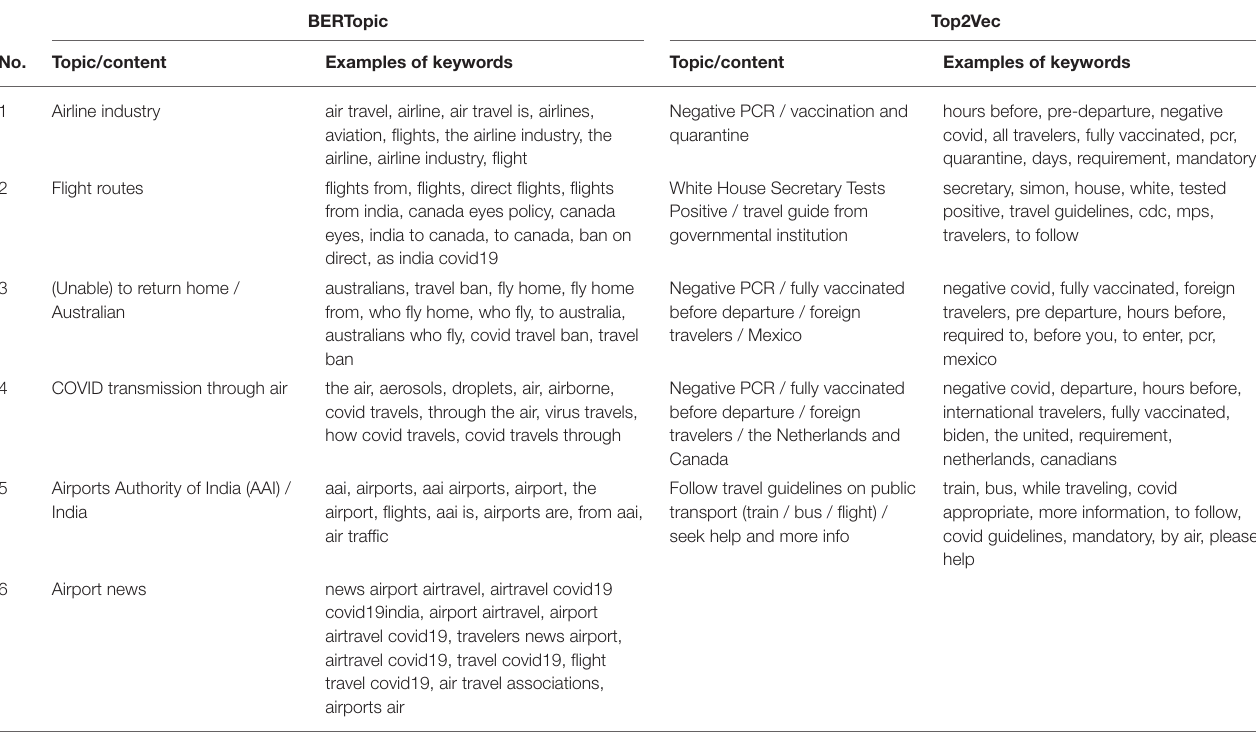
TABLE 2 | Topics identified by BERTopic and Top2Vec for “flight.”